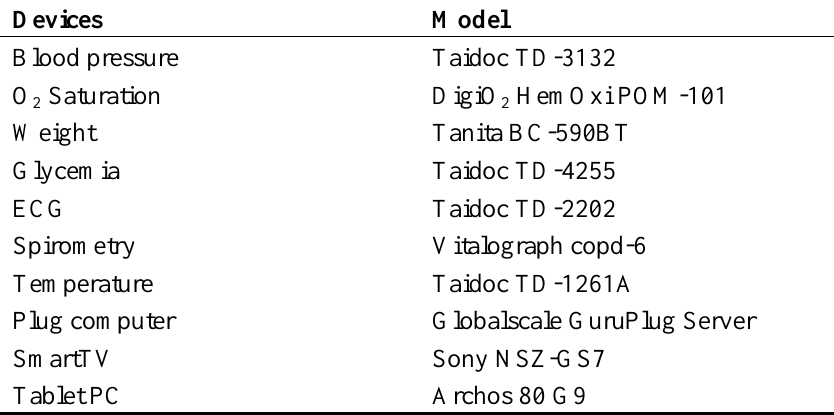
Table 4. Integrated devices for healthcare